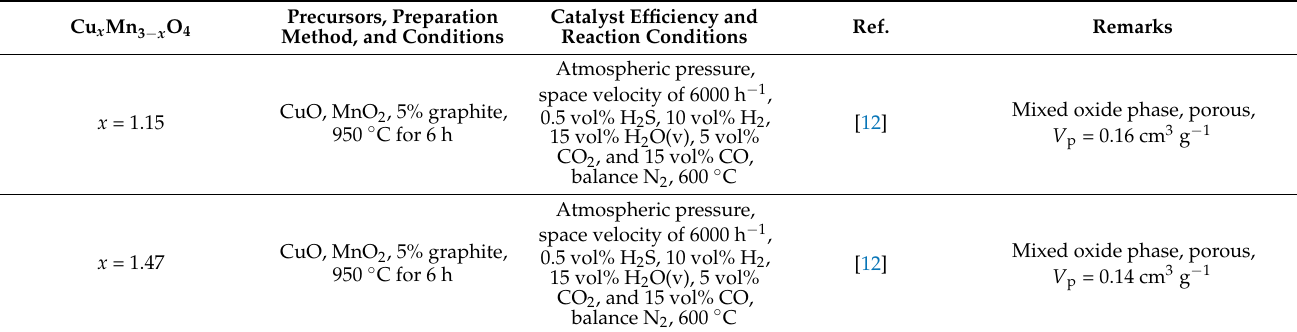
Table 6. Desulfurization with Cu x Mn 3 − x O 4